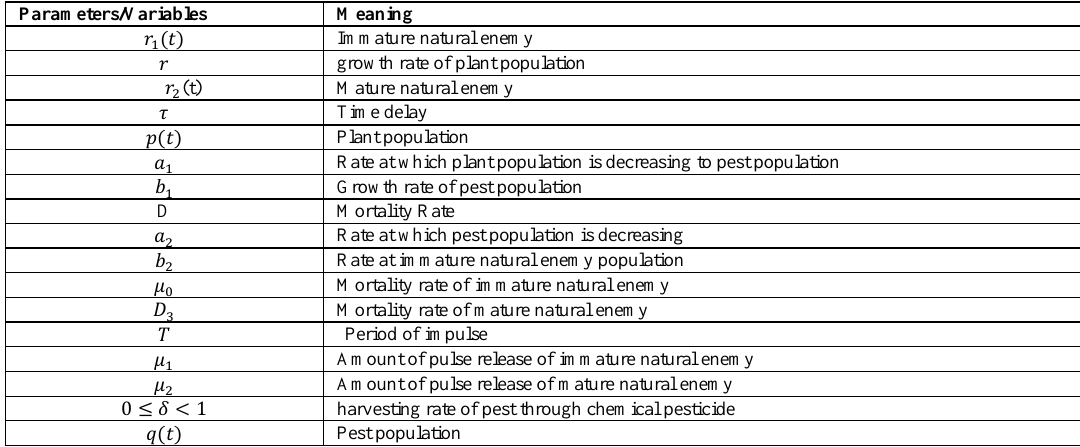
Table. 1 Meaning of parameters